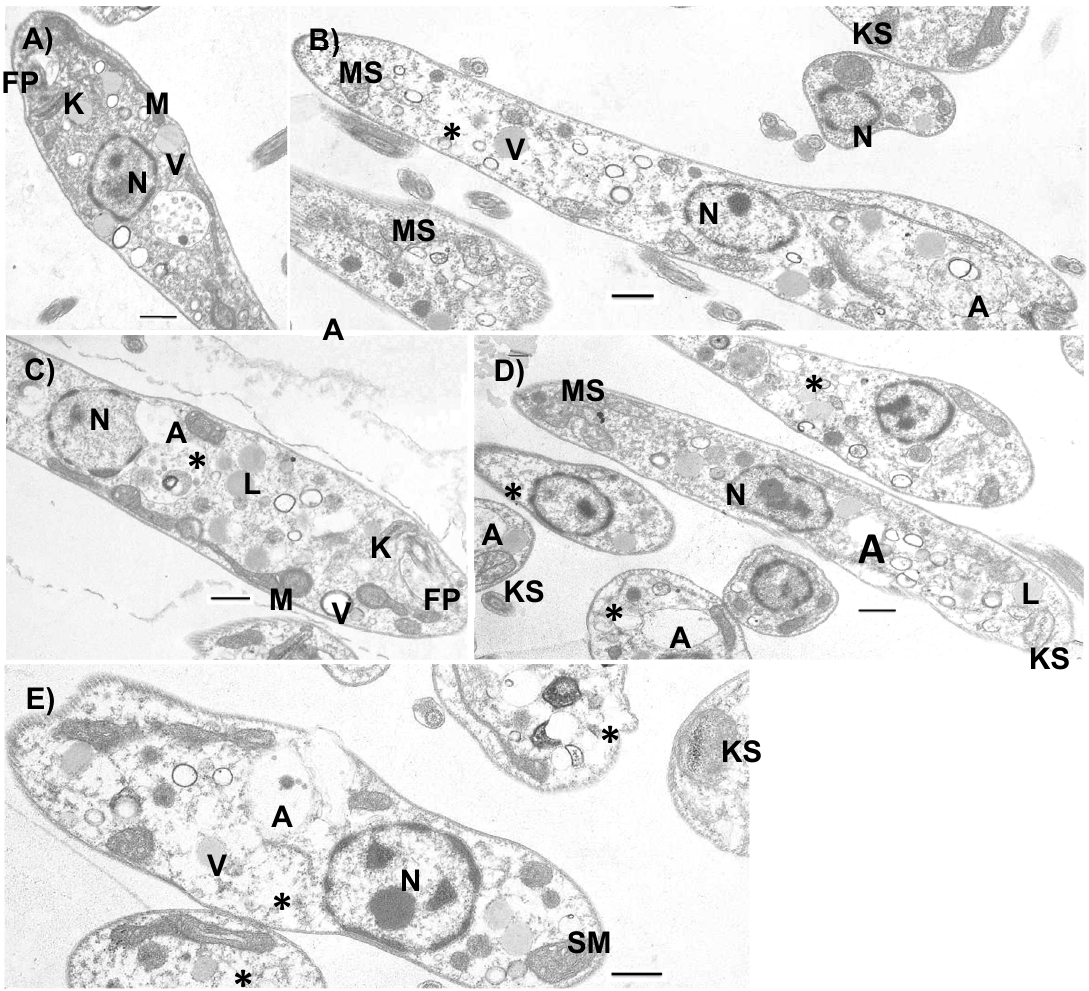
Figure 2. Transmission electron micrographs of Leishmania infantum promastigotes exposed to Lavandula luisieri essential oil. ( A ) Control parasites; ( B – E ) parasites treated with essential oil. Note mitochondrial swelling (MS) ( B , D , E ) and kinetoplast swelling ( B , D , E ), gross alterations in the organization of cytoplasm (*) ( B – E ). N, nucleus; K, kinetoplast; F, flagellum; FP, flagellar pocket; A, autophagic vesicles; V, cytoplasm vesicles. Bars, 2 µm.